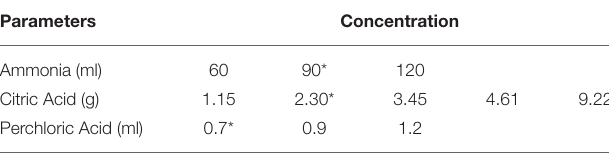
TABLE 1 | Concentration variations of